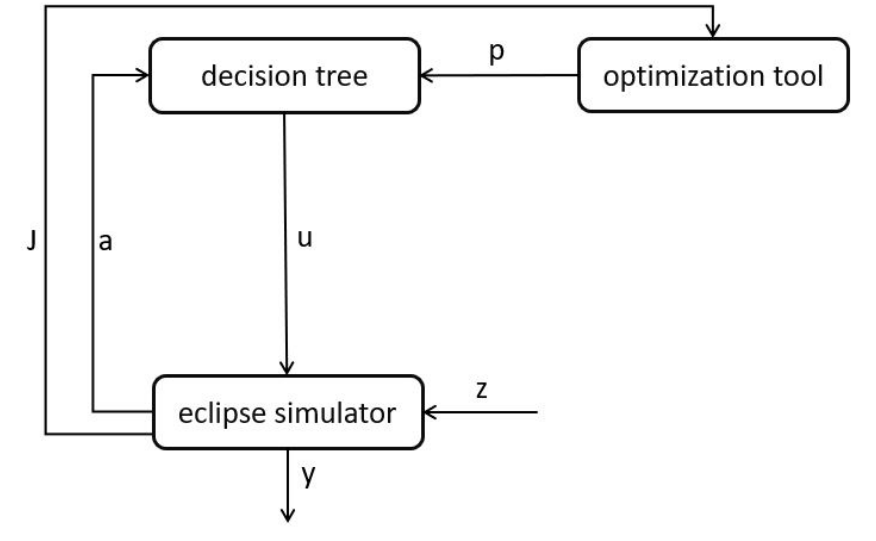
Figure 3. Diagram of the constructed closed-loop extreme control